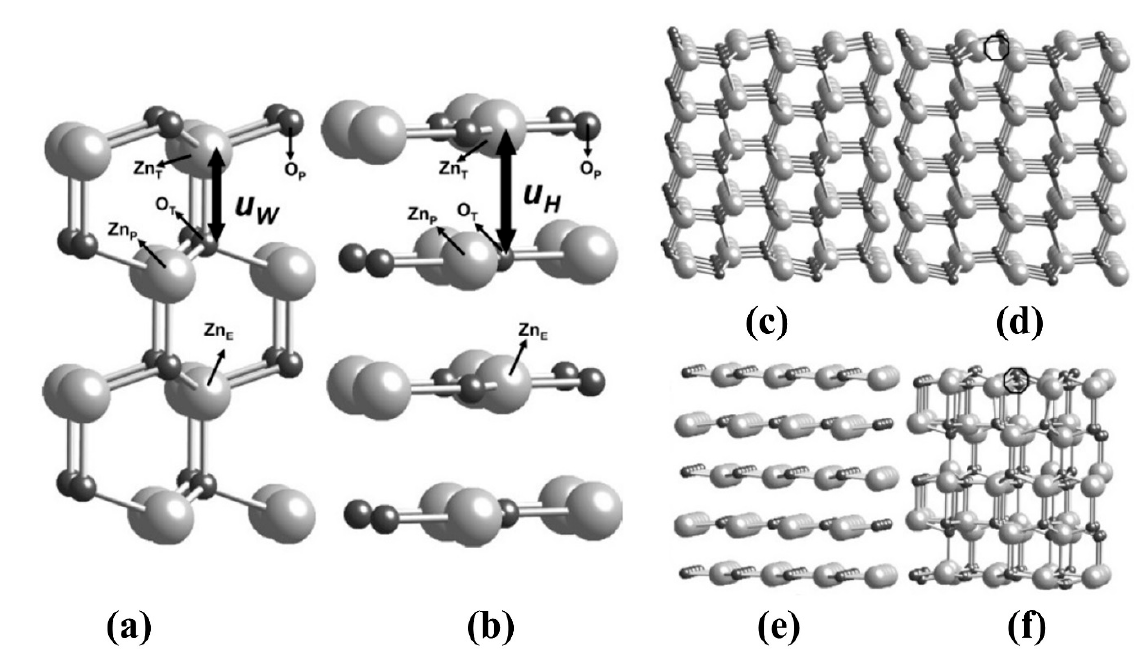
Figure 3. ( a ) Ball and stick model of ZnO with wurtzite structure. The light spheres denote Zn atoms while dark spheres denote O atoms. Zn and O atoms are in different planes ( b ) ZnO with hexagonal structure. Both O and Zn atoms are in the same plane ( c ) ZnO stoichiometric structure with five layers, ( d ) ZnO stoichiometric structure after removing O atom, ( e ) Single layer ZnO stoichiometric structure, and ( f ) Single layer ZnO stoichiometric structure after removing O atom. Reprinted with permission from Reference [47]. Copyright 2007, with permission from the American Chemical Society.